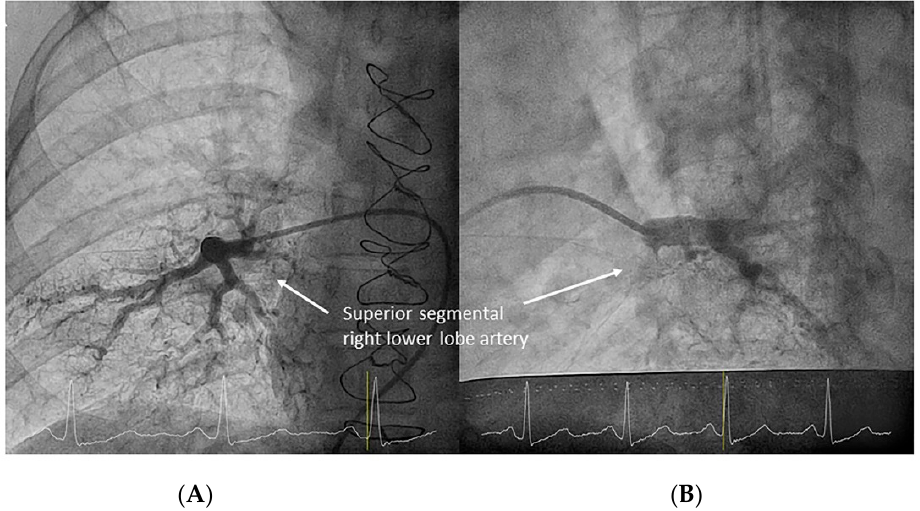
Figure 17. Right lower lobe superior segmental branch (A6). ( A ) anteroposterior view. ( B ) lateral view.